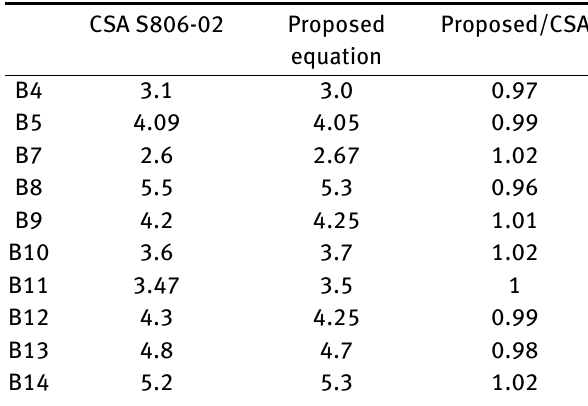
Table 3: The shear bearing capability calculated using